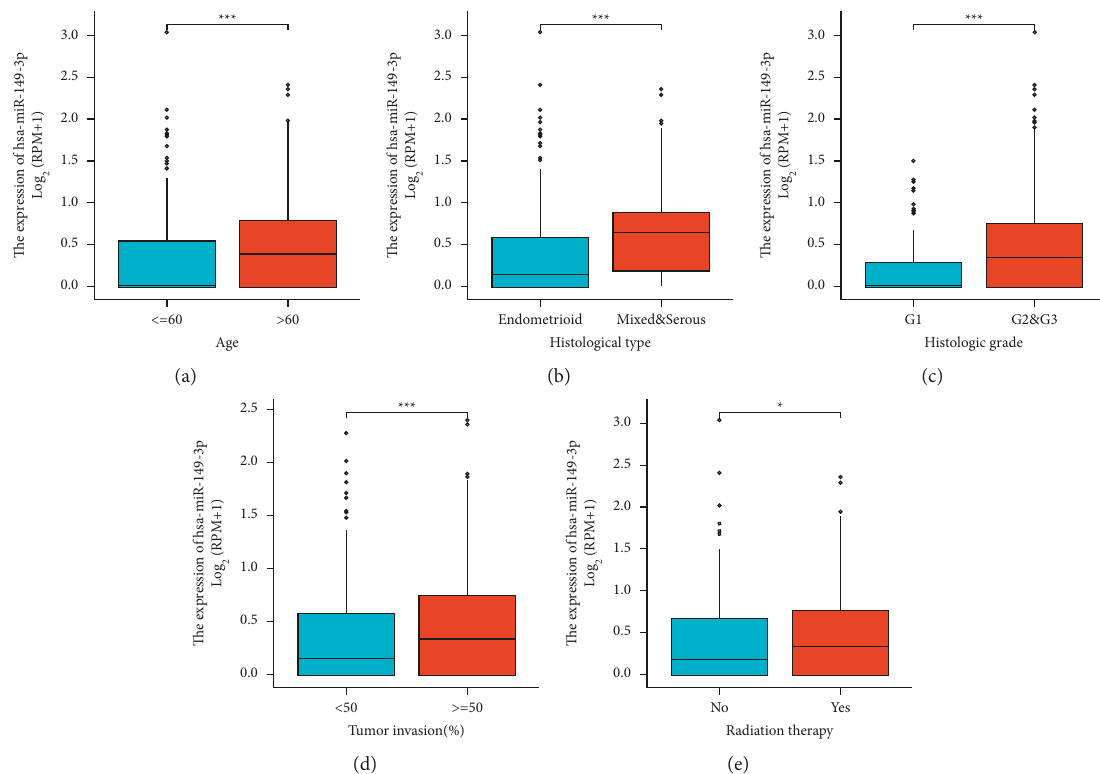
Figure 2: Association with miR-149-3p expression and clinical stage in UCEC. (a) Age, (b) histological grade, (c) histological grade, (d) tumor invasion, and (e) radiation therapy. Significance markers: ∗ P < 0 . 05; ∗∗∗ P < 0 . Table 2: miR-149-3p expression correlated with clinical and pathological features (logistic regression analysis). Characteristics